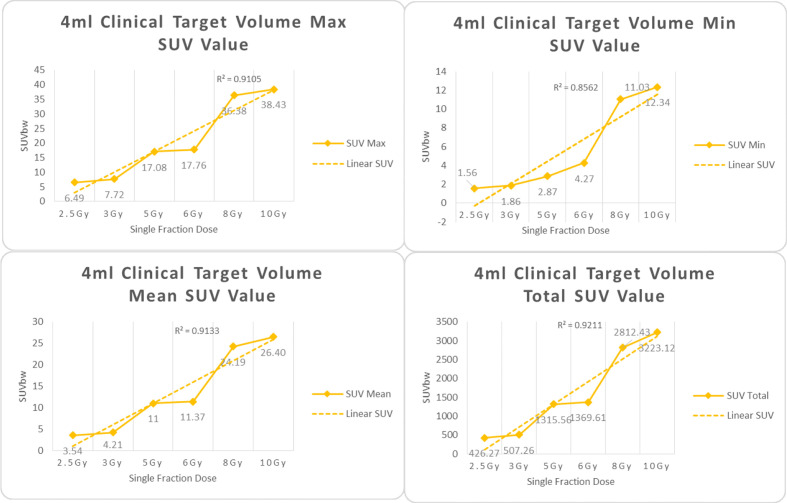
Maximum, minimum, average, and overall SUV of 4 ml clinical volume for different target doses.